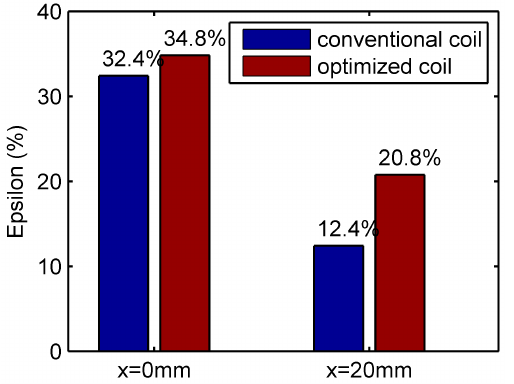
Figure 11. Simulation Results—Comparison of reduction in (cid:2035) of the conventional coil and optimized coil for centered and off-center rivets.